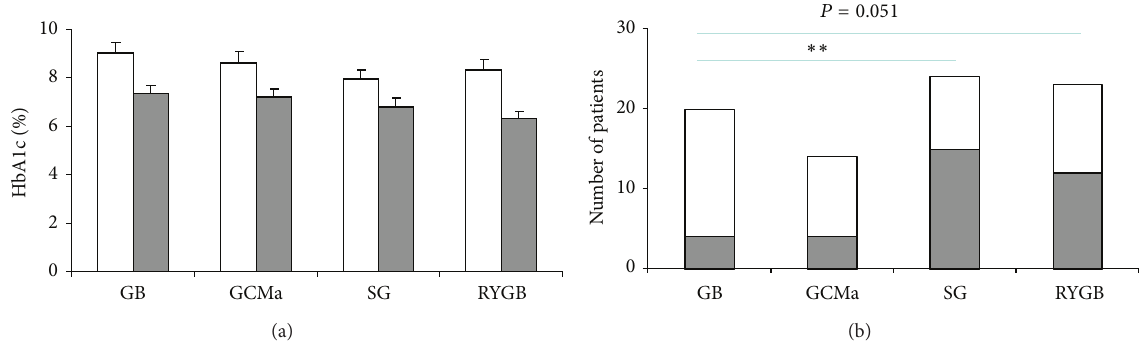
Figure 4: Impact of bariatric surgery on the evolution of diabetes in diabetic obese patients. (a) changes in serum HbA1c levels (mean ± SEM) observed in obese diabetic patients following each of the four different types of bariatric surgery. White columns represent serum HbA1c levels measured before surgery and grey toned columns represent the value measured one year after surgery. (b) Number of patients in whom remission of the diabetes was observed after bariatric surgery. White columns represent the total number of patients operated for each type of surgery. Grey toned zones show the number of patients in whom a remission of diabetes was observed. Gastric banding (GB), calibrated gastrectomy type Mason (CGMa), sleeve gastrectomy (SG), and Roux-en-Y gastric bypass (RYGB). ∗∗ 𝑃 < 0.01